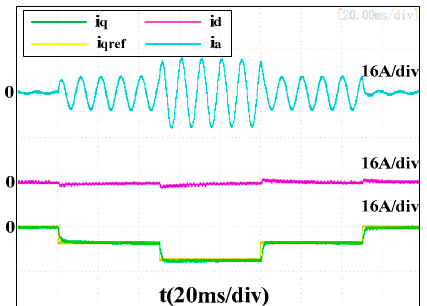
Figure 12. d-q axis current waveform of the conventional current controller with feedback decoupling at 6000 rpm with Kp = 500 π Ls.